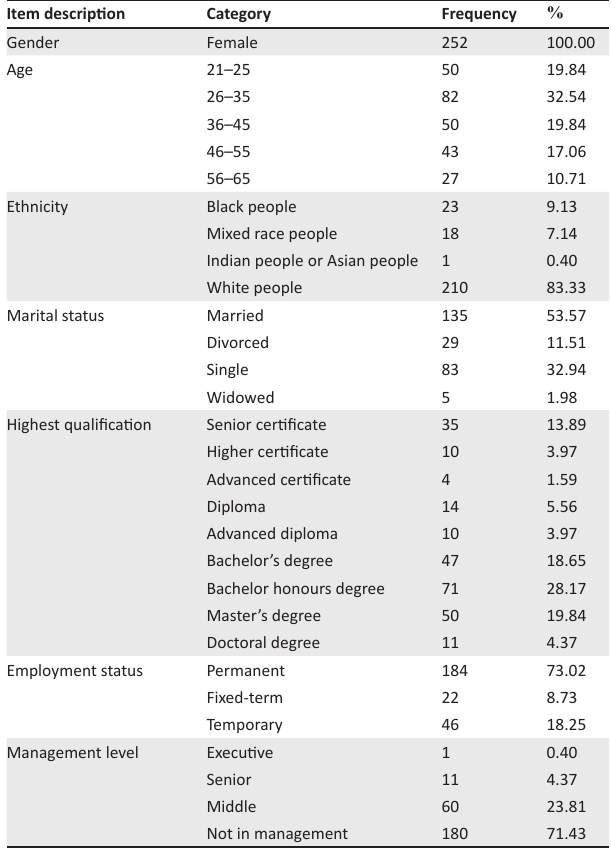
TABLE 1: Participant